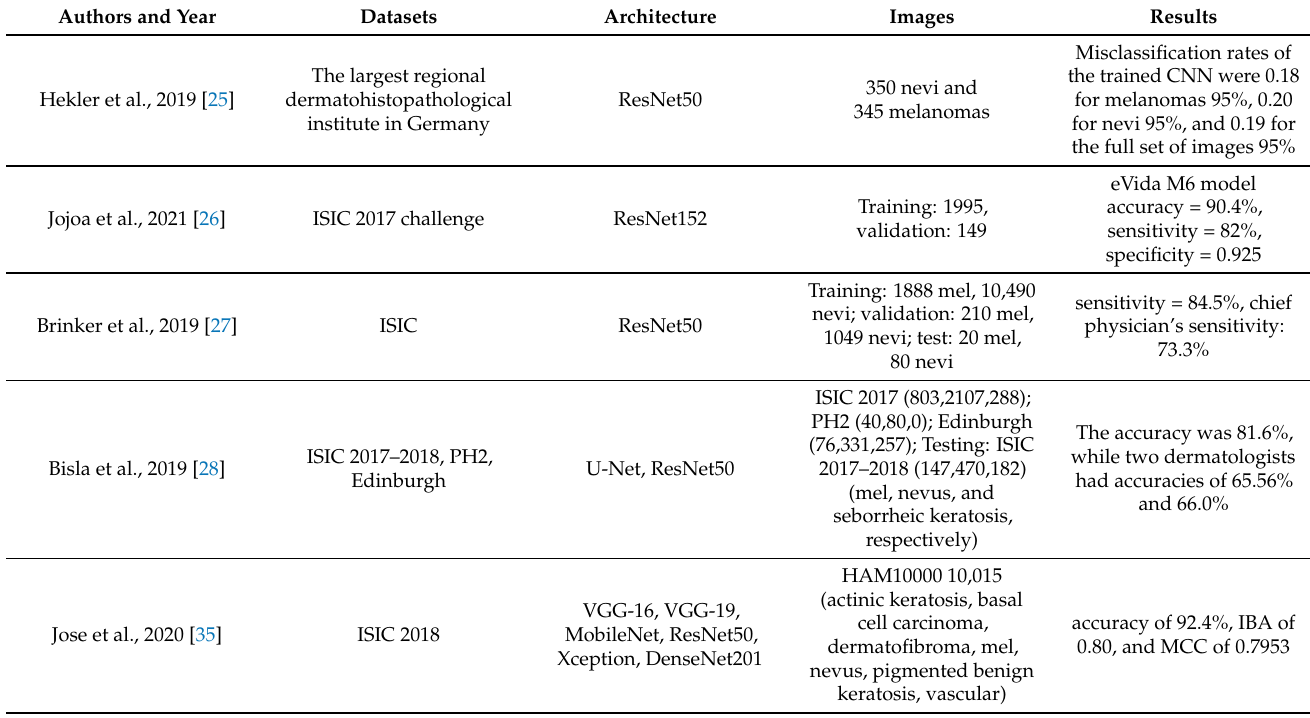
Table 1. Summary of the most important previous